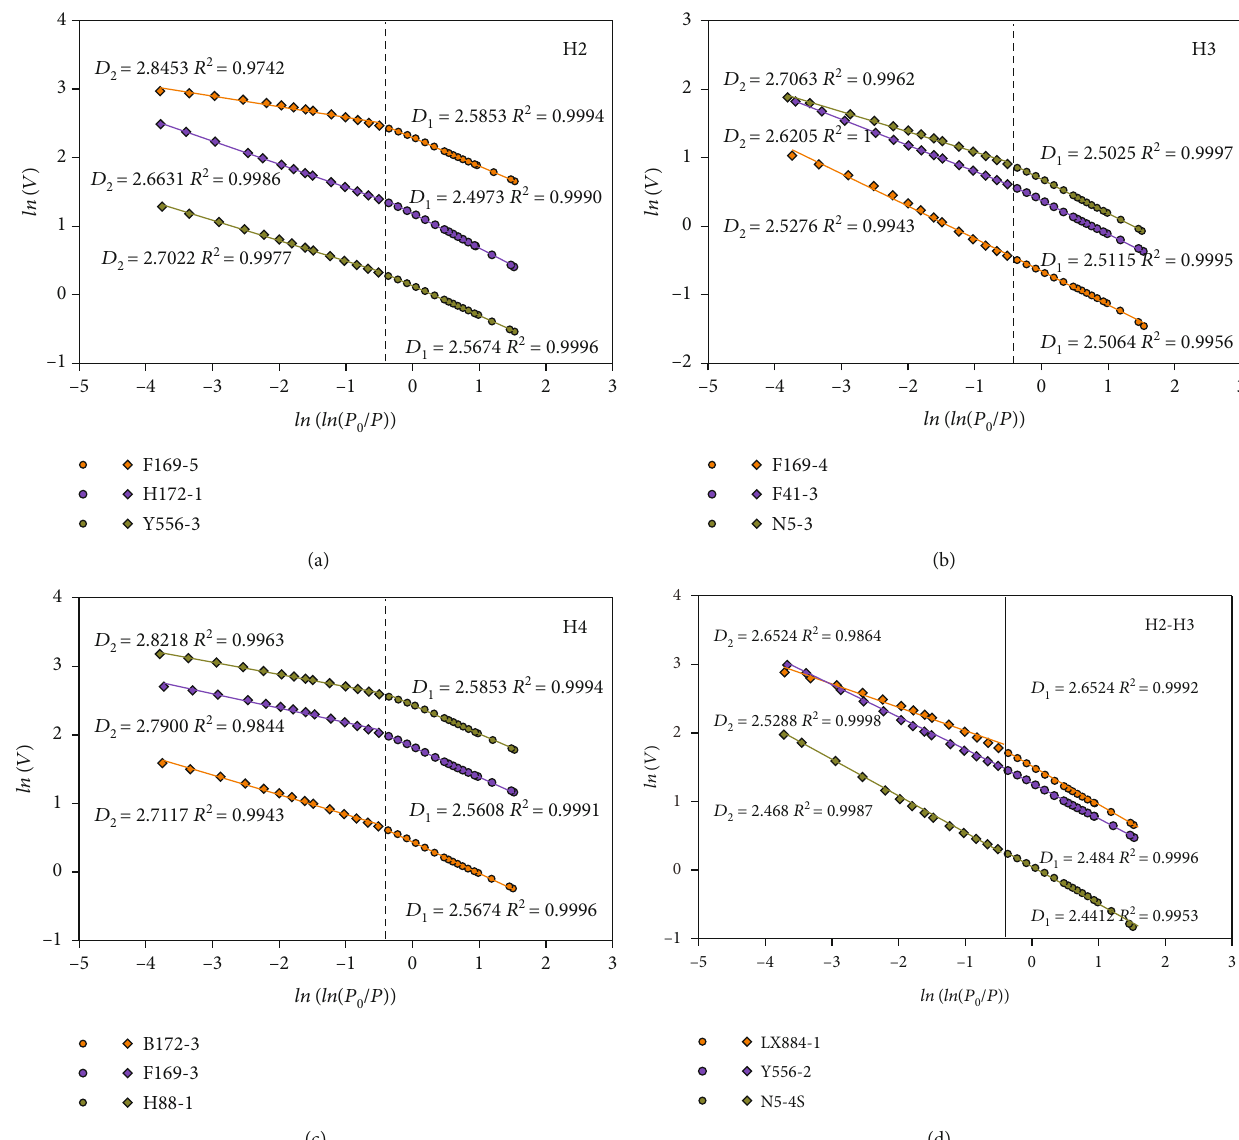
ÞÞ of nitrogen adsorption from 0